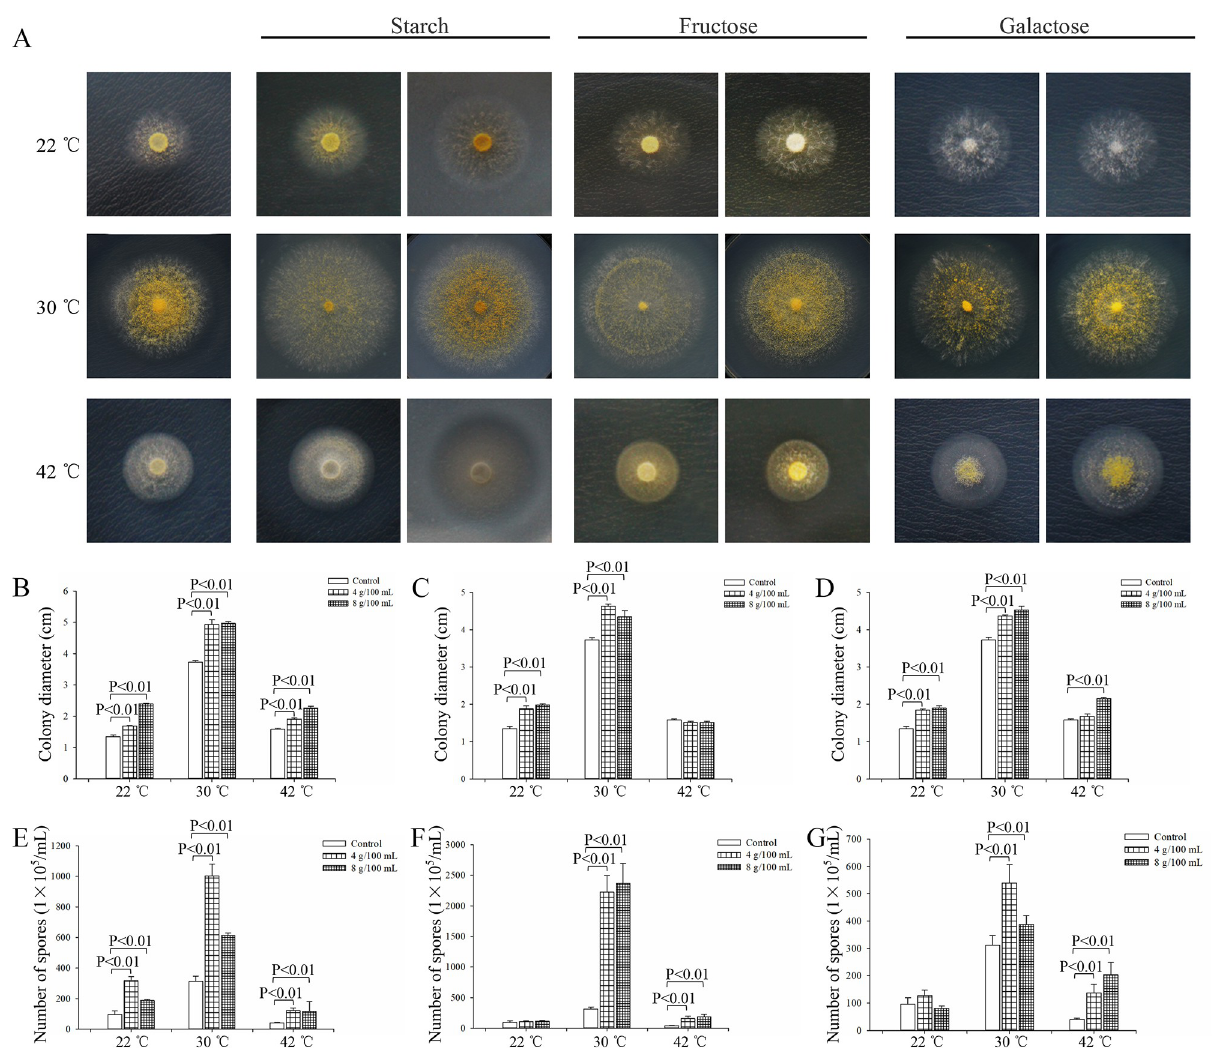
Fig 7. Effects of exogenous sugar on the growth of A . oryzae under low and high-temperature stress. (A) Phenotypes of A . oryzae cultured on CD medium supplemented with 4 and 8 g/100 mL of starch, fructose, and galactose or 96 h. (B-D) The colony sizes of A . oryzae cultured on CD media supplemented with starch, fructose, or galactose, respectively. (E-G) The spore density of A . oryzae cultured on CD media supplemented with starch, fructose, or galactose, respectively. CD medium with no sugar was used as the control. The values represent the average of three replicates ± SD, at a P < 0.01 level of